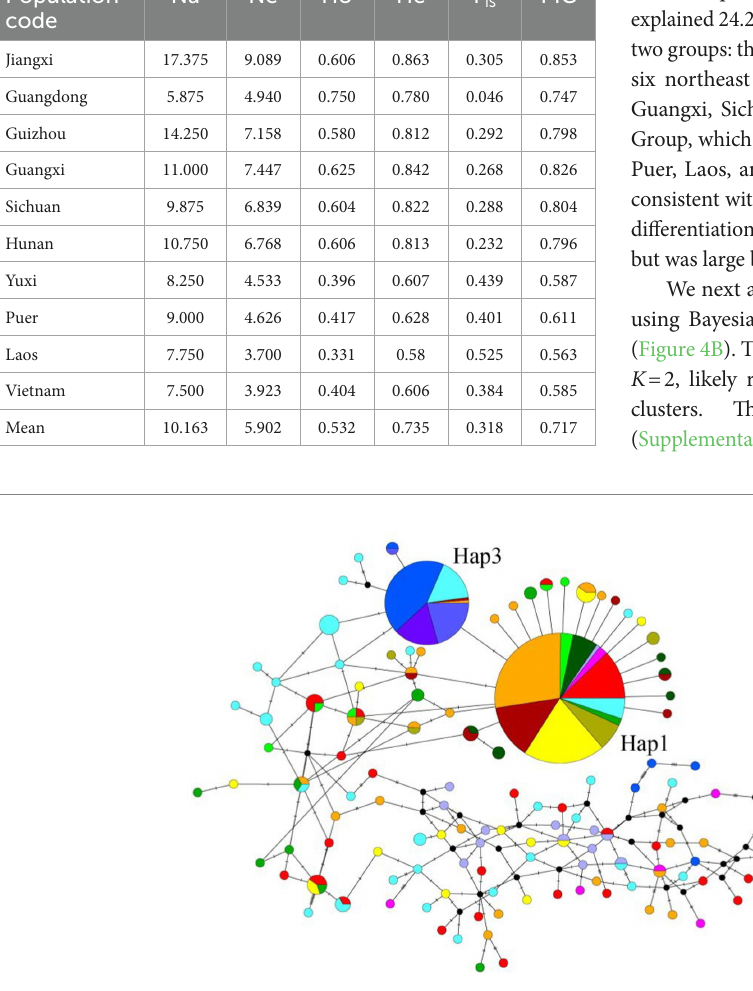
TABLE 2 Genetic diversity on microsatellite data in the bamboo grasshopper. Population